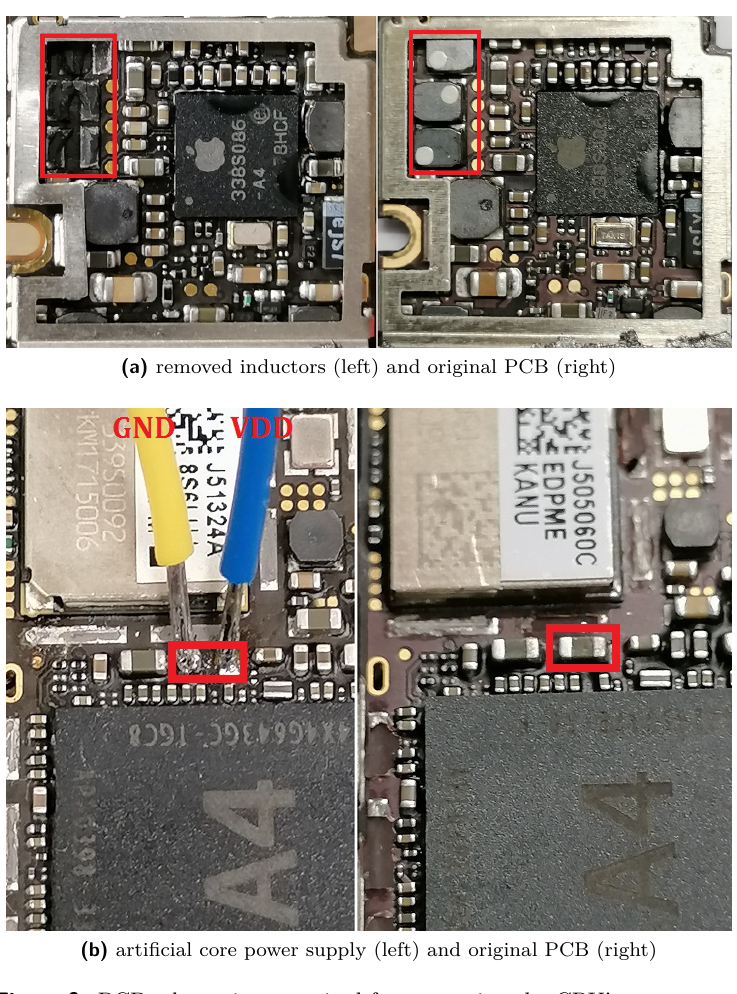
Figure 9: PCB adaptations required for measuring the CPU’s core